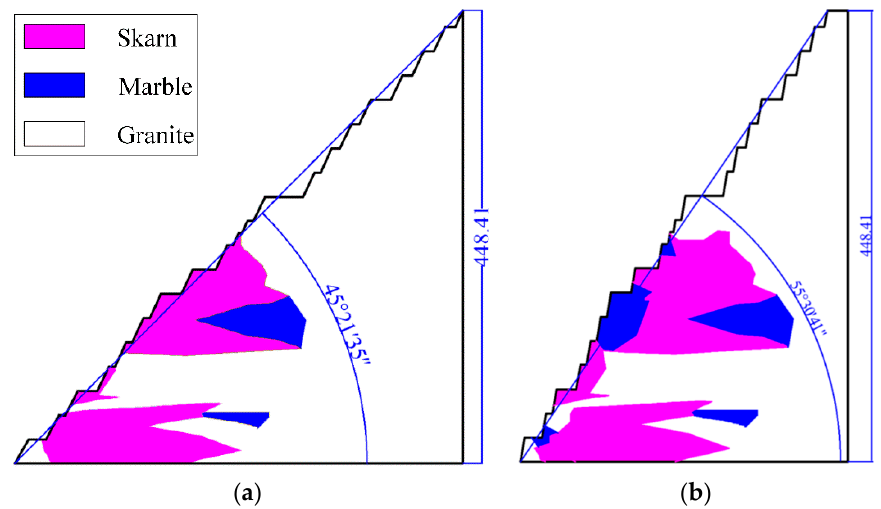
Figure 10. R3 slope profile after step slope angle adjustment: ( a ) pre-adjustment; ( b ) after adjustment.